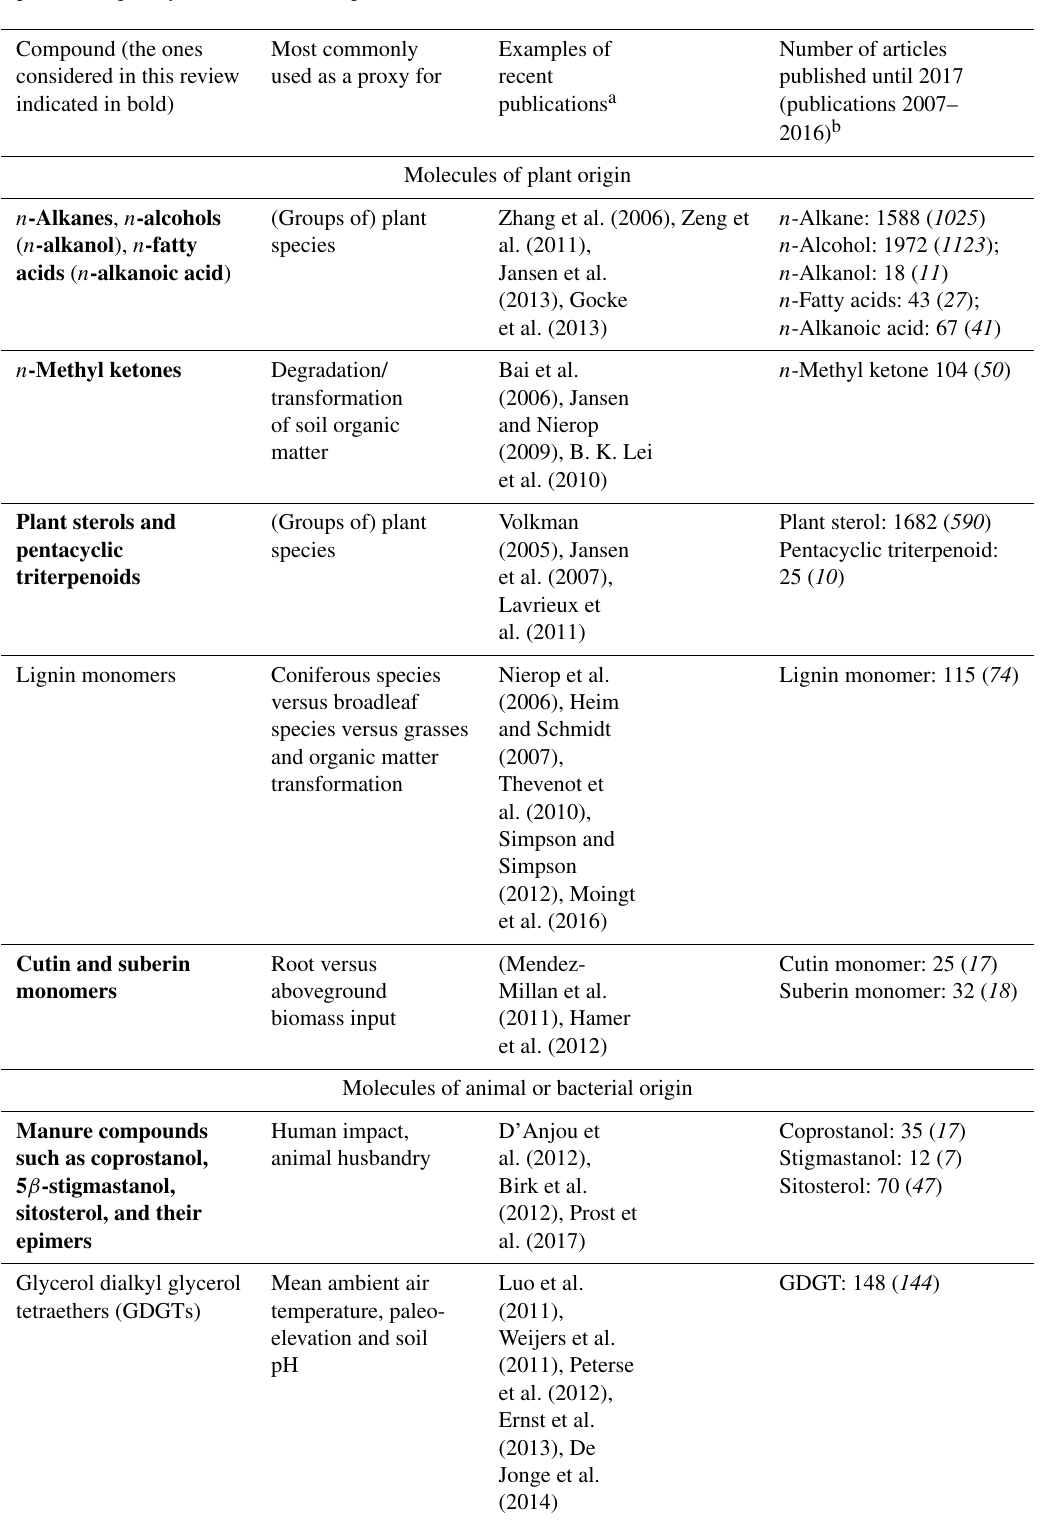
Table 1. Compounds frequently used as molecular proxies in soils. Compound (the